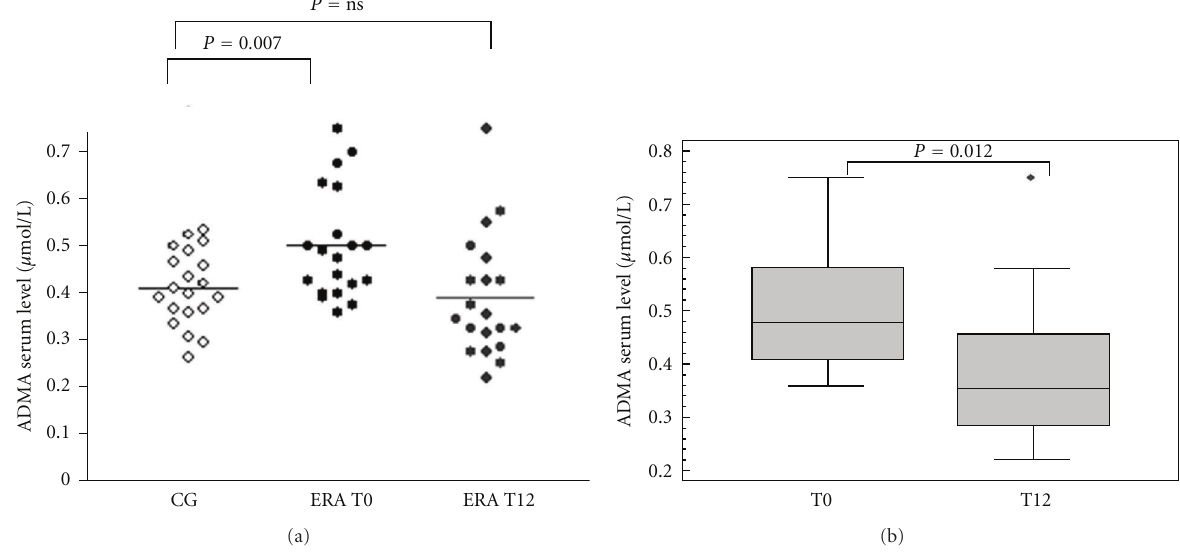
Figure 1: ADMA serum levels in ERA patients and controls (a) and in ERA patients before and after treatment (b). CG: control group; ERA: early rheumatoid arthritis.